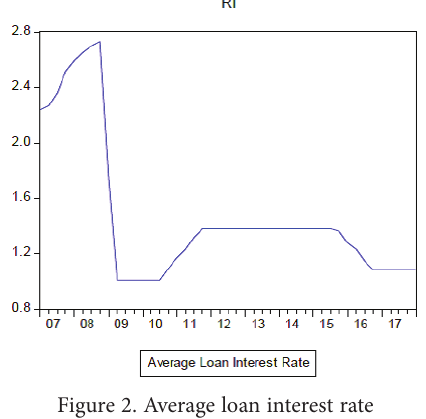
Figure 1. Main categories of consumption Figure 2. Average loan interest rate